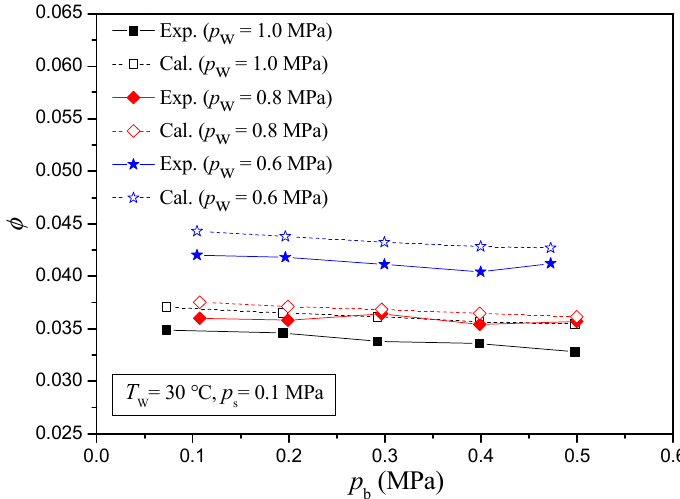
Figure 7. ϕ comparisons for different back pressures. Figure 7. φ comparisons for different back